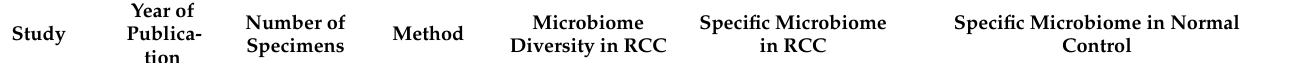
Table 1. Cont. Different Microbiome in Normal and RCC